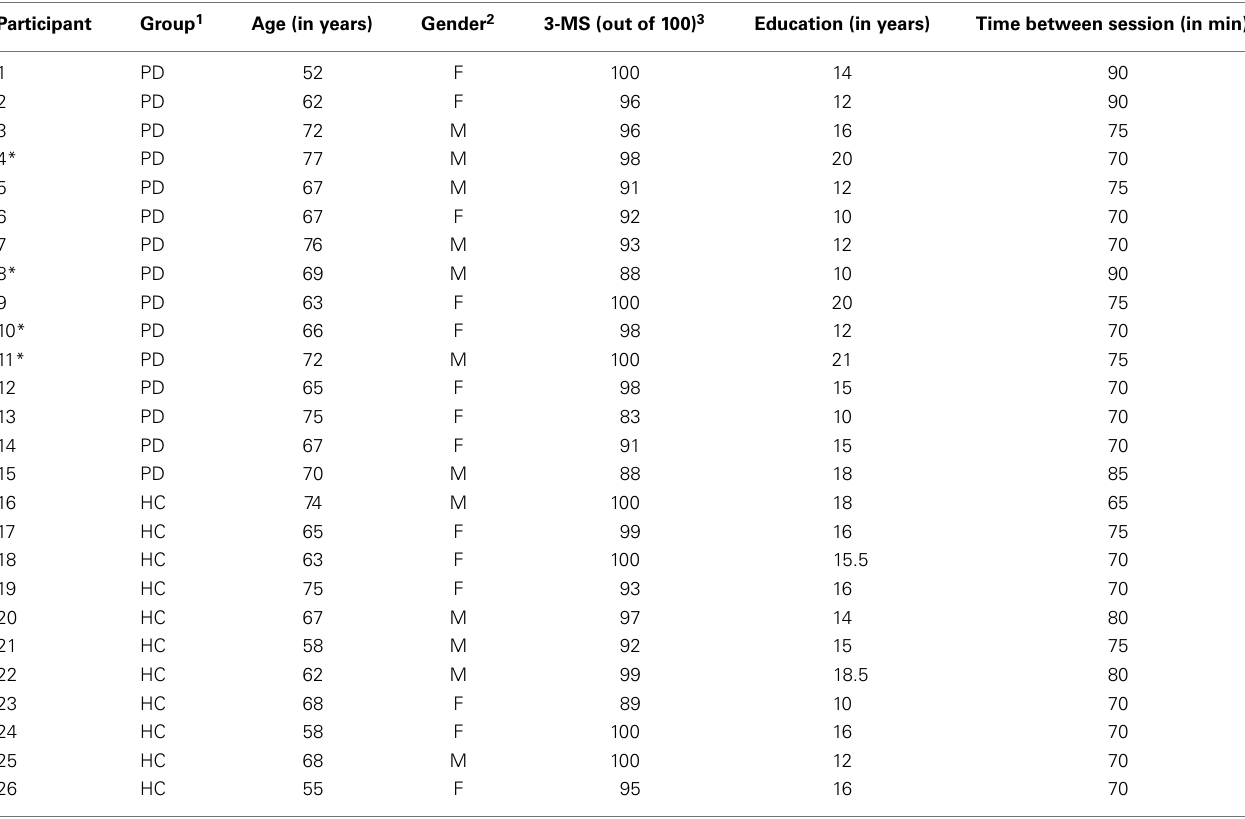
Table 1 | Demographic information of healthy comparison and PD